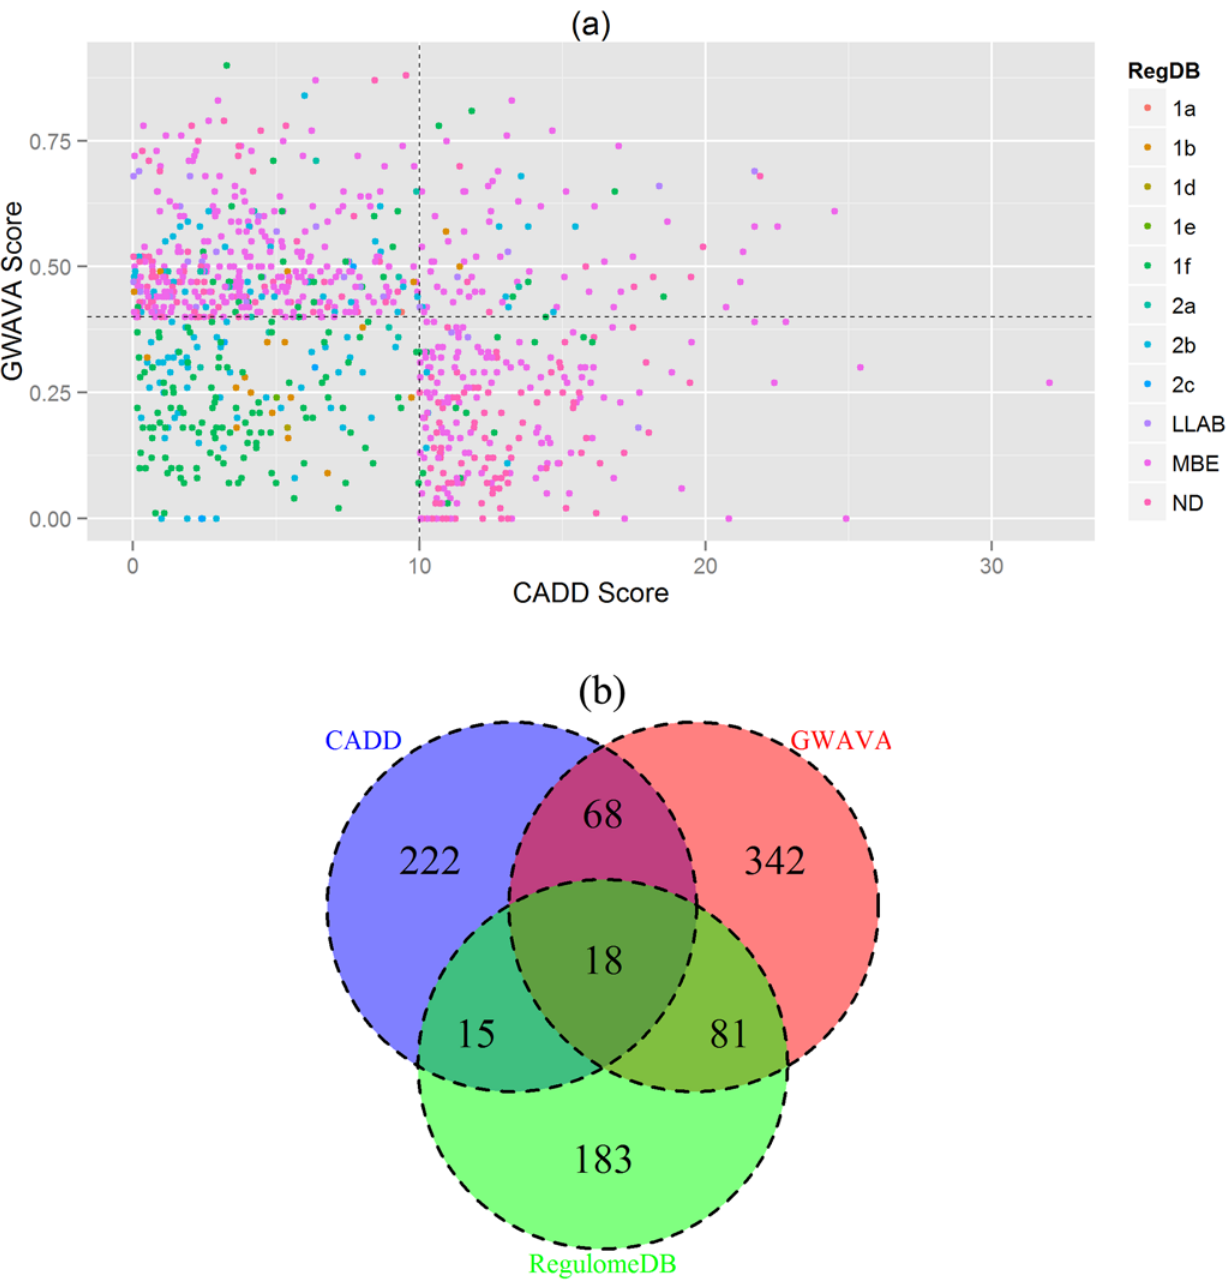
Fig 5. Concordance Analysis. ( a ) Scatterplot depicting top annotation scores from CADD, GWAVA and RegulomeDB. Each point represents a single SNP where CADD scores are in the x axis , GWAVA scores in the y axis and RegulomeDB annotation scores are shown with colors. The plot is divided into four segments using y intercept = 0.4 and x intercept = 10. Top right segment contains 18 SNPs with highest annotation scores from the three classifiers. ( b ) Venn diagram illustrating the number of SNPs in concordance with the three classifiers. Here CADD scores are in blue, GWAVA scores are in red and RegulomeDB scores are in green. The intersection of three circles represents SNPs in concordance with all three classifiers. Note: Cutoff scores used for concordance analysis are: CADD (cid:1) 10, GWAVA (cid:1) 0.4 and RegulomeDB (cid:3) 2. Based on this cutoff, 929 SNPs are plotted in the scatterplot and Venn diagram (after removing the overlap). RegDB : RegulomeDB annotation score; LLAB : Less likely to affect binding (includes category 3a and 3b); MBE : Minimal binding evidence (includes category 4, 5 and 6); ND : No Data.